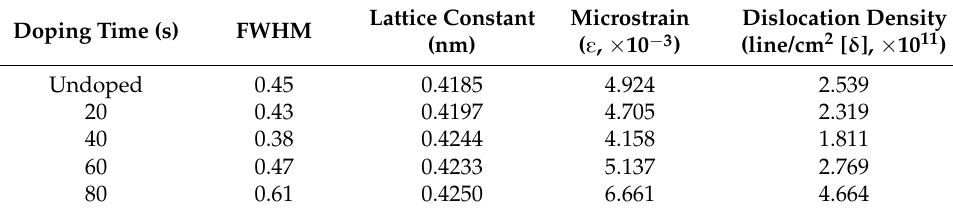
Table 2. Structural parameters of Cr–NiO along the (200)